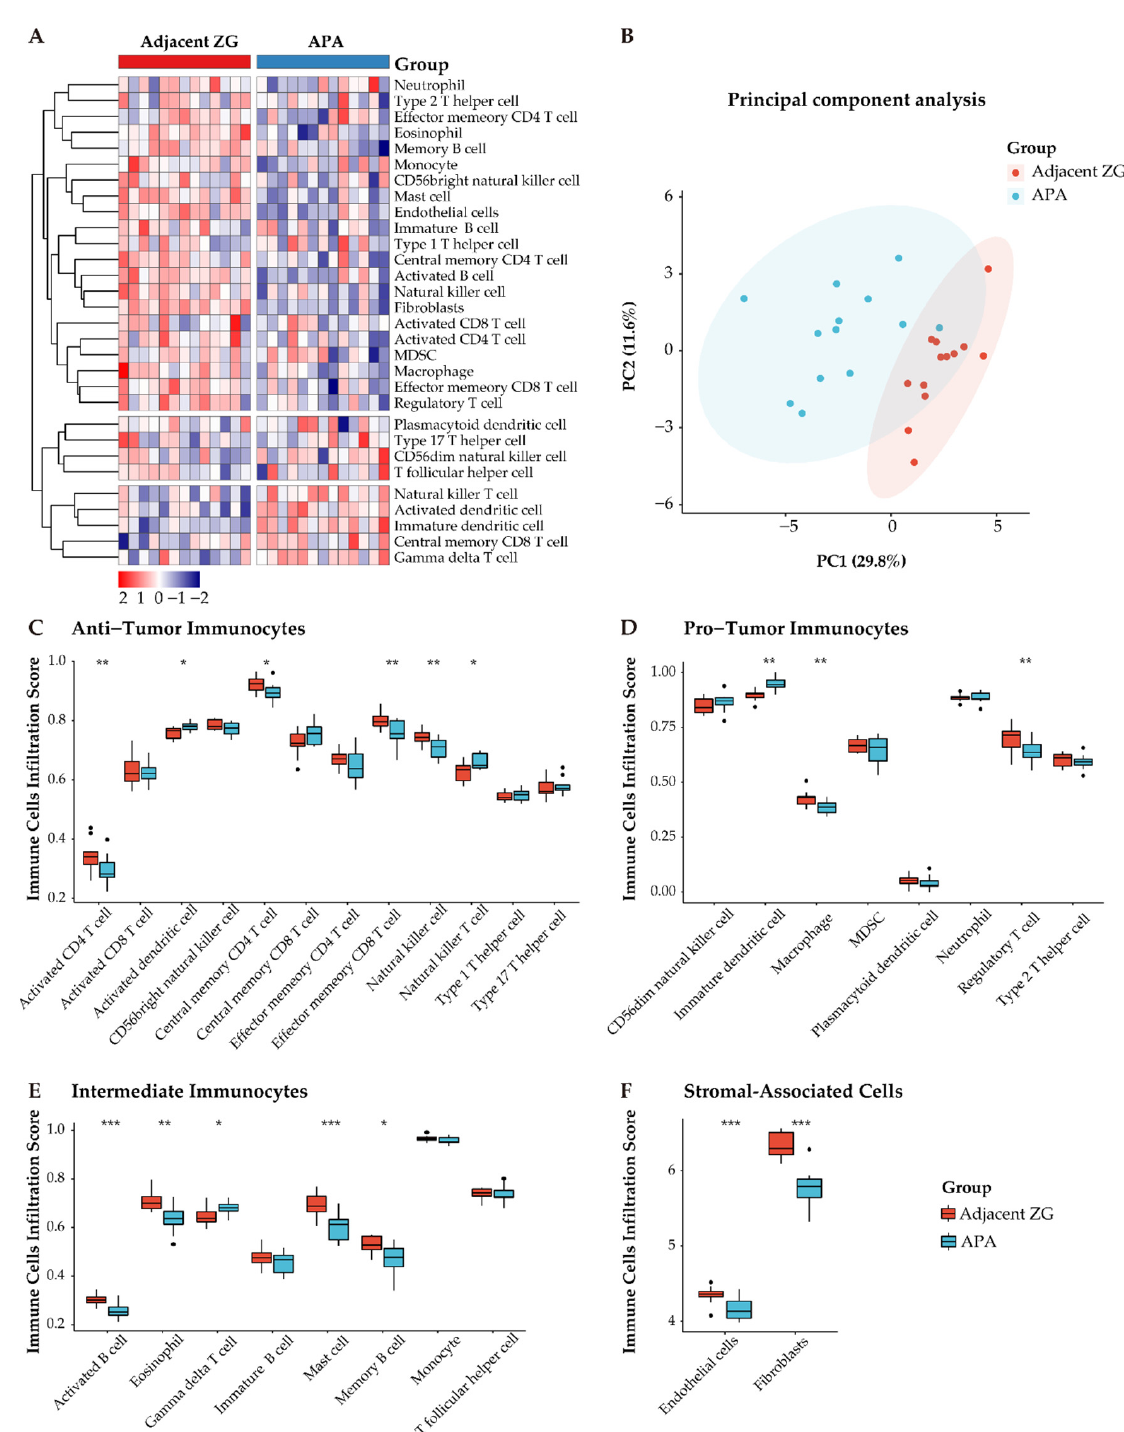
Figure 6. Distinct immune microenvironment landscapes in APA versus paired adjacent zona glomerulosa (ZG). ( A ) Heatmap of 28 tumor infiltration cells between APAs and adjacent ZG (GSE64957). MDSC, myeloid-derived suppressor cells. ( B ) Principal component analysis (PCA) of tumor-infiltrating cells. Two distinct groups were plotted in two-dimensional space: APA and adjacent ZG. PC, principal component. ( C – E ) Boxplot of the proportions of tumor microenvironment immune cells in ( A ) using the ssGSEA algorithm. ( F ) Boxplot of the proportions of TME stromal associated cells in ( A ) using MCP-counter algorithm. Box plots: scattered dots, immune score of the two subgroups; middle lines, median value; bottom and top of the boxes, 25th–75th percentiles. ns, not significant; * p < 0.05; ** p < 0.01; *** p < 0.001 by paired Wilcoxon test. APA, aldosterone-producing adenoma; ZG, zona